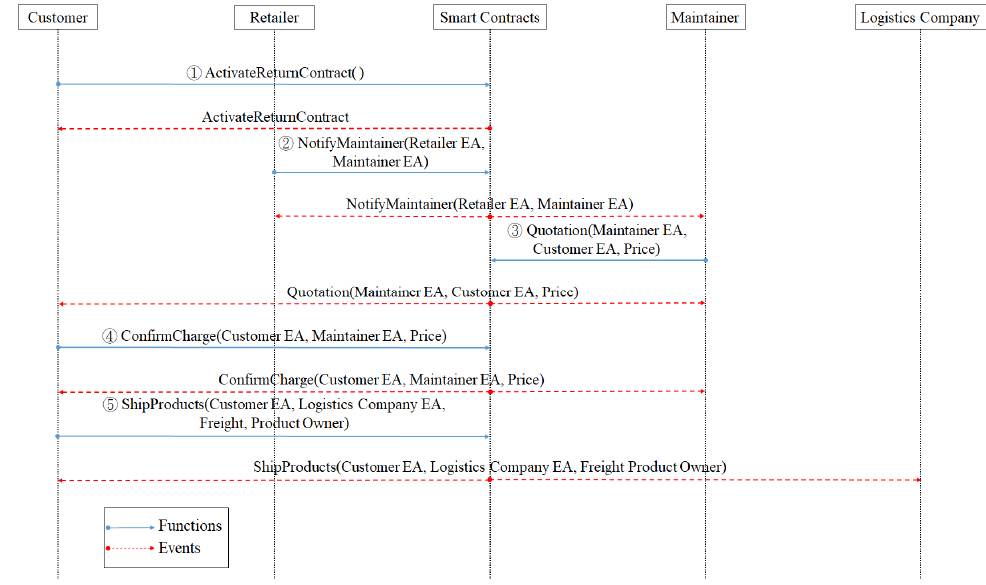
Figure 4. System Sequence Diagram 1.